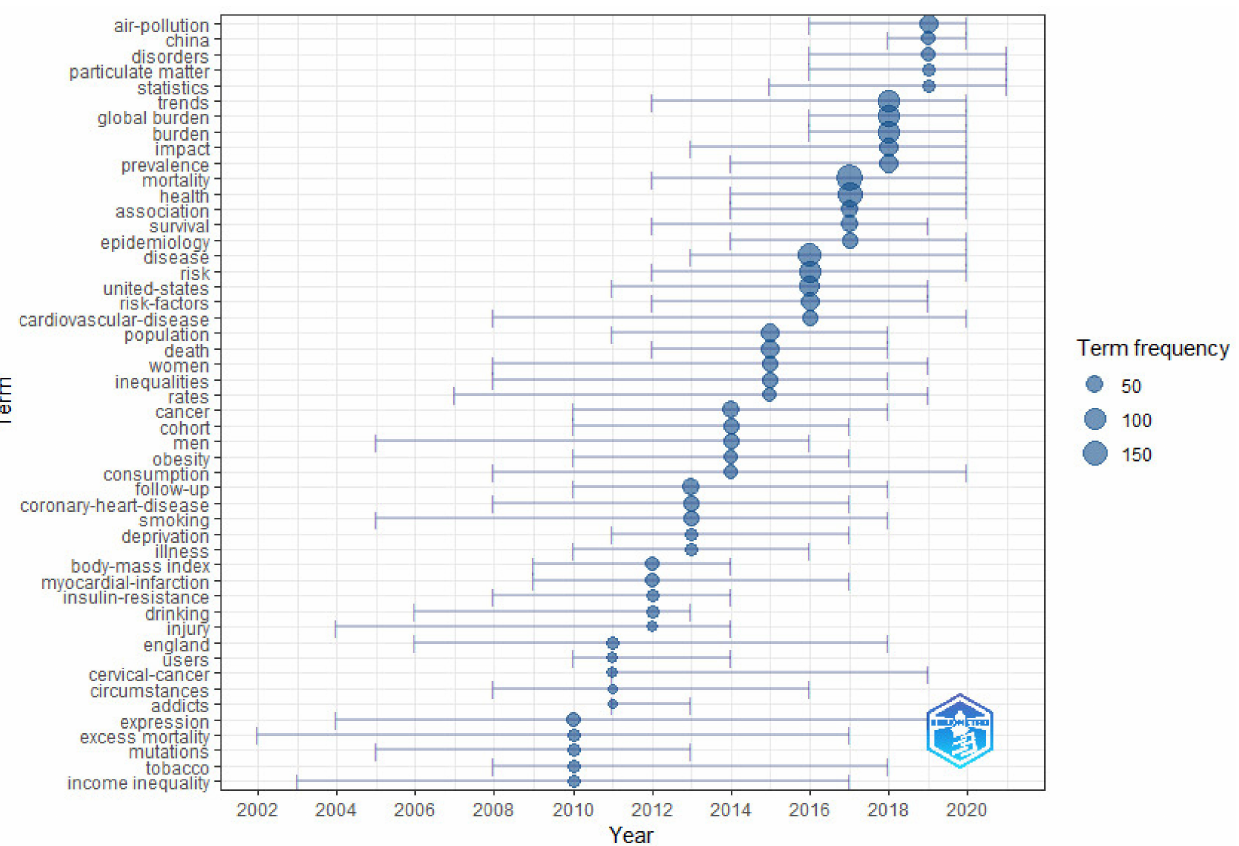
Figure 5. Trending keywords related to premature mortality between 2002 and